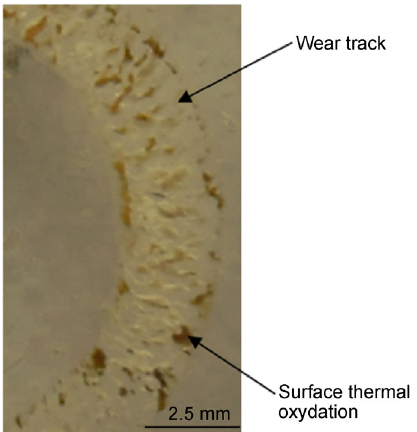
Fig. 5 Surface color modification after dry sliding test of Ep sample at F n = 8 N and V = 1,000 rpm.